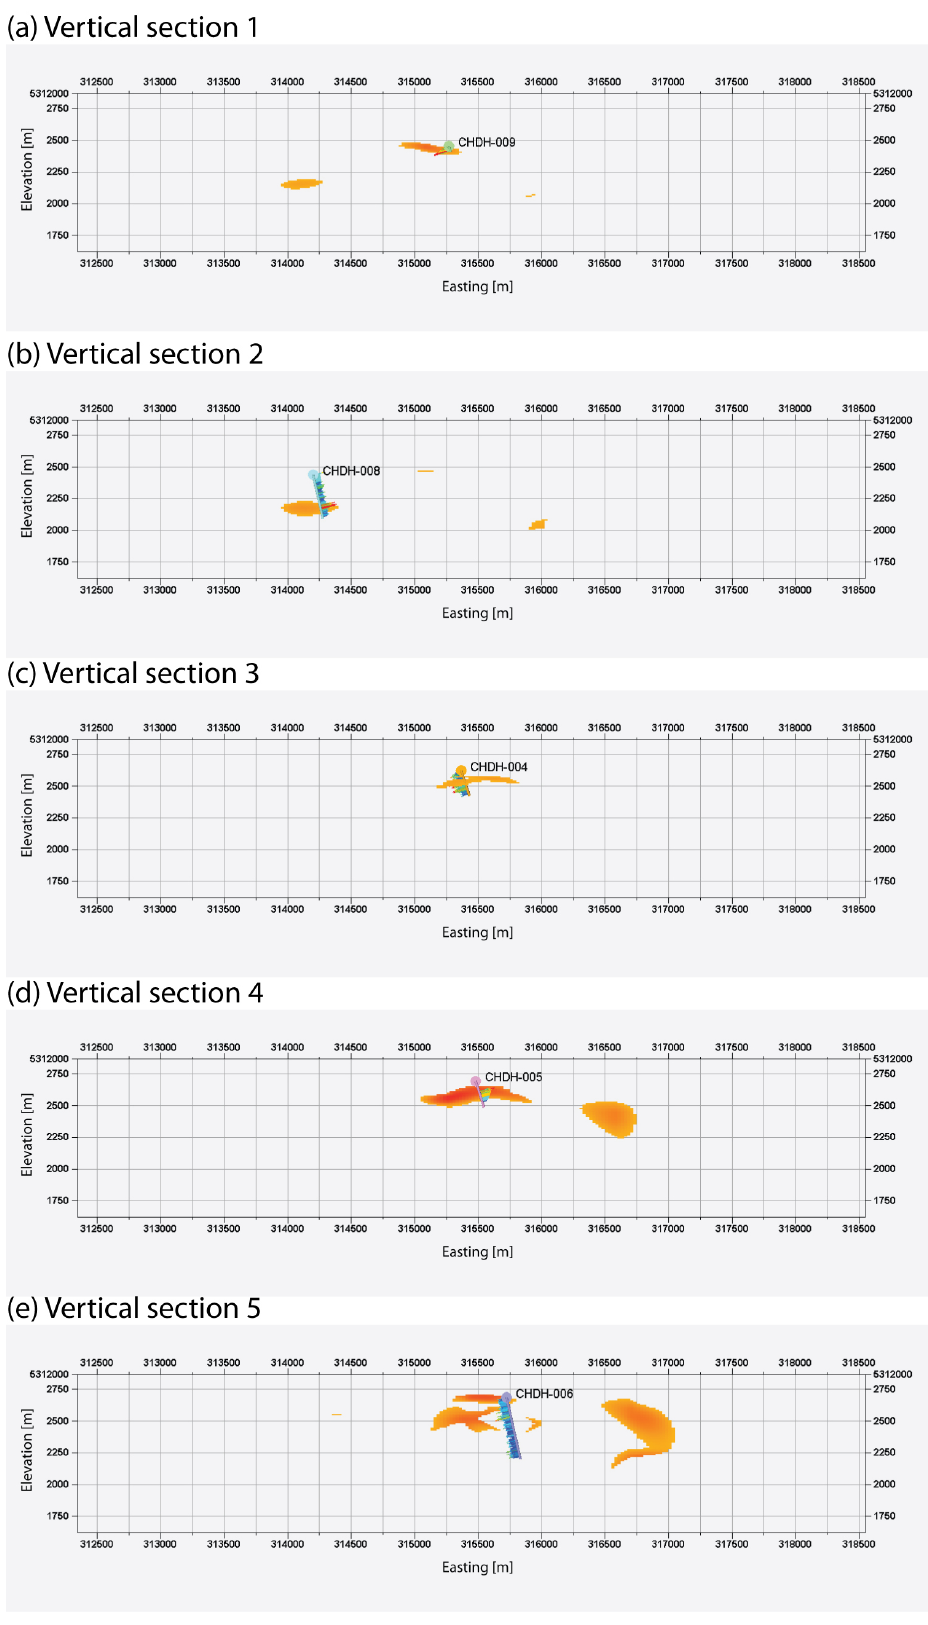
Figure 19. Vertical cross sections of the 3D interpreted target mineralized zones along ( a ) section 1, ( b ) section 2, ( c ) section 3, ( d ) section 4, and ( e ) section 5 in Figure 18, with assay